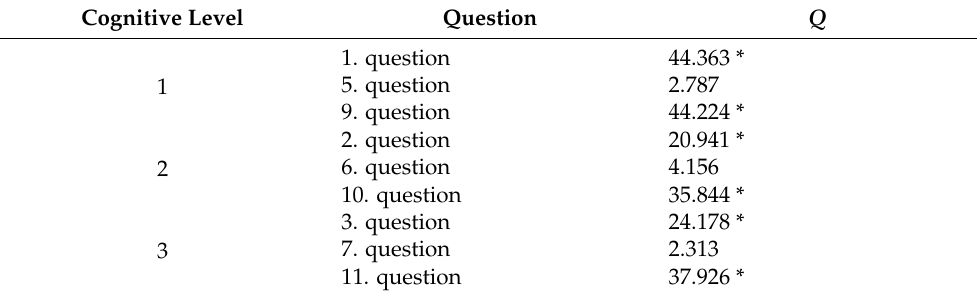
Table 3. Results of the Stuart-Maxwell test (pre-test and post-test).